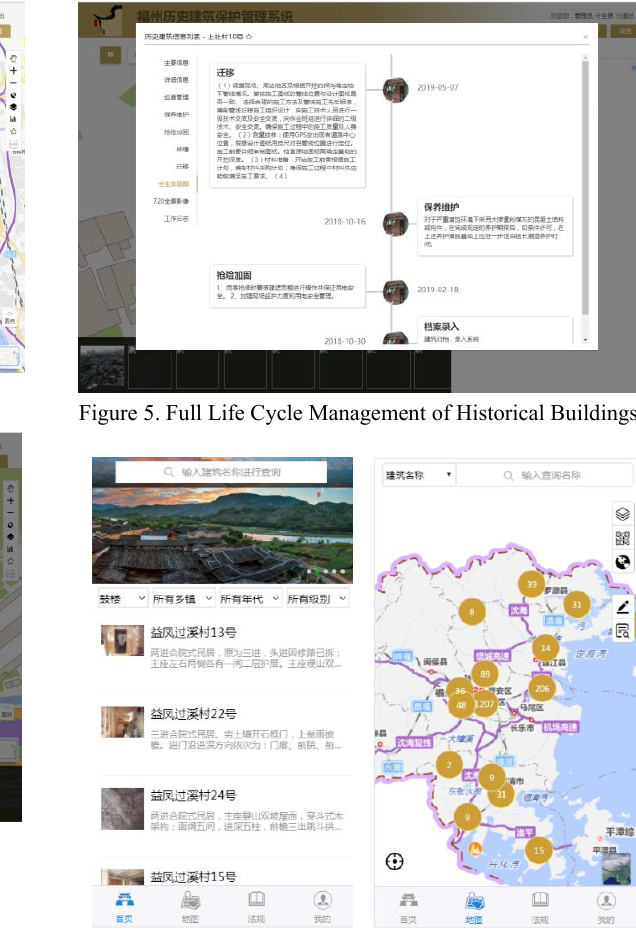
Figure 6. Mobile App based on